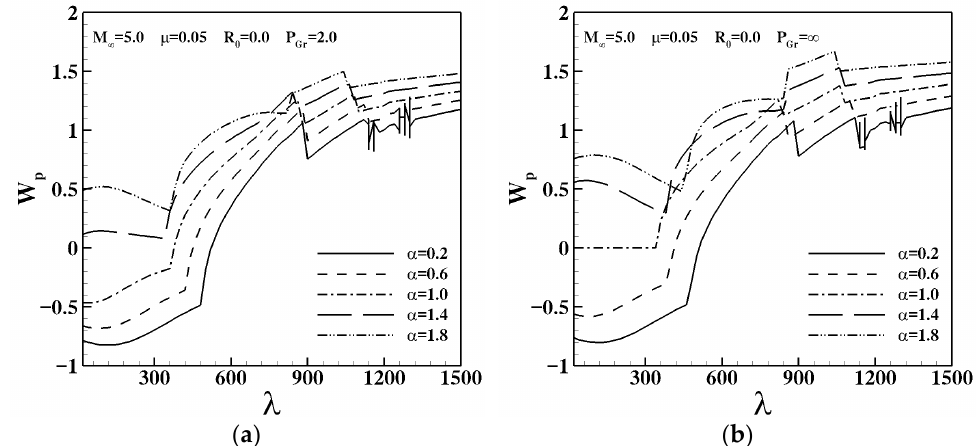
Figure 11. Peak of deformation versus dynamic pressure under different coefficients of head-panel pressure: ( a ) P Gr = 2.0; ( b ) P Gr = ∞ .